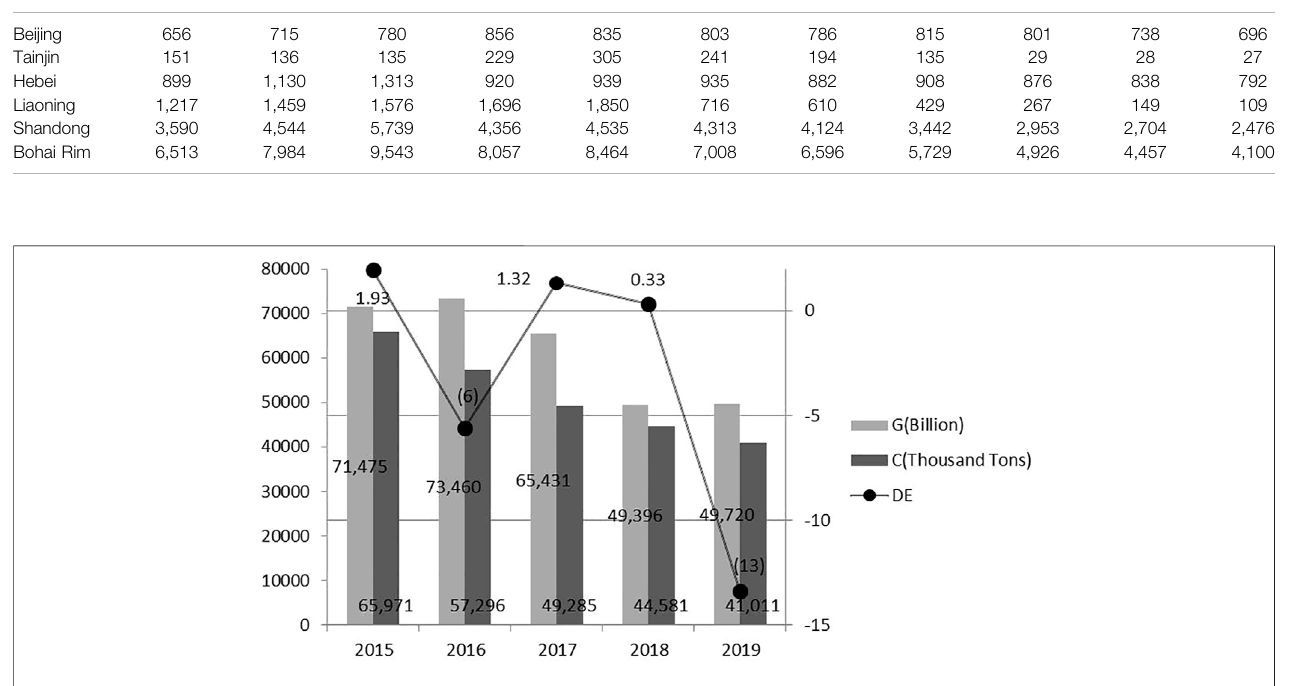
FIGURE 1 | Decoupling